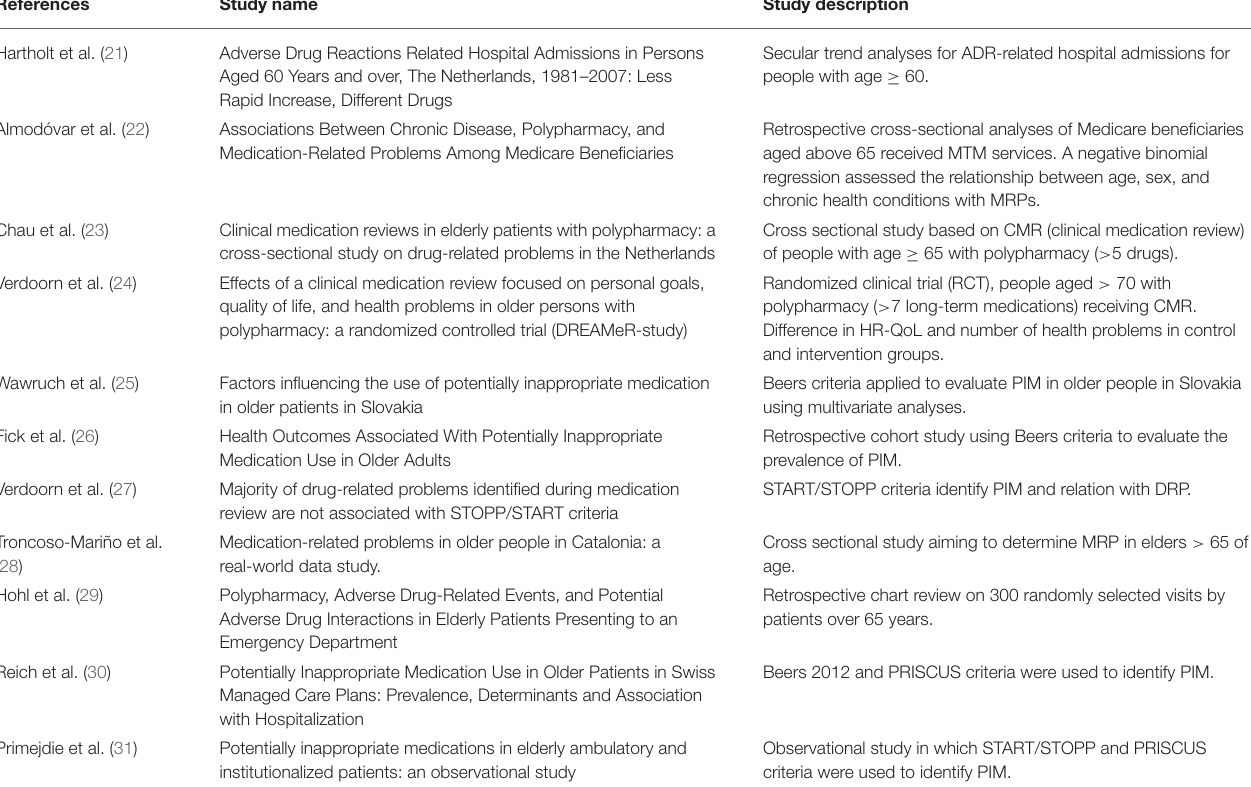
TABLE 2 | Included studies and their respective criteria.